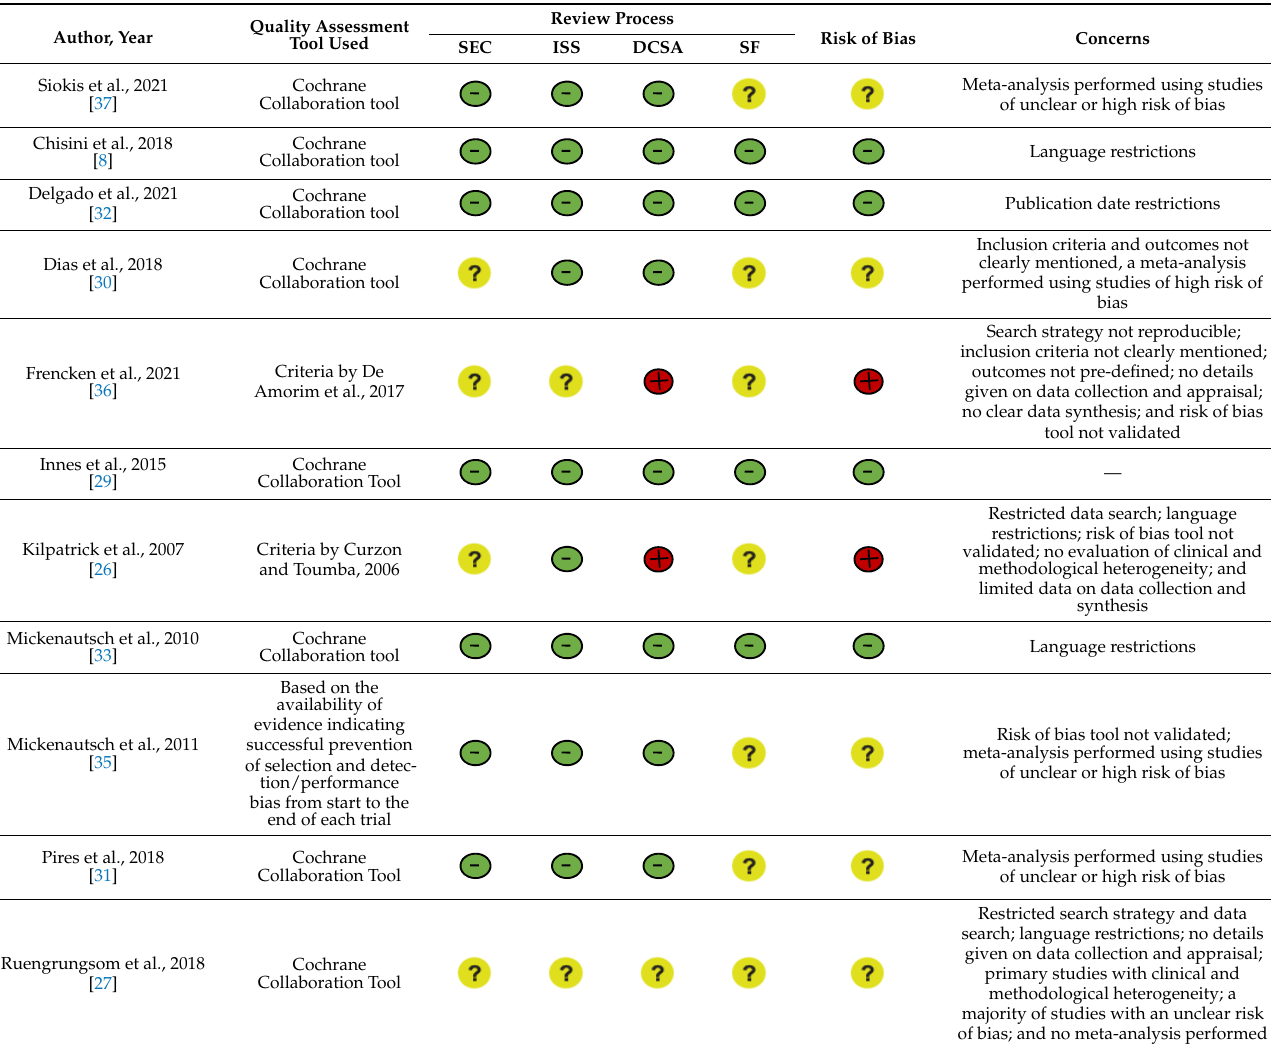
Table 2. Quality assessment of included reviews using the ROBIS tool.